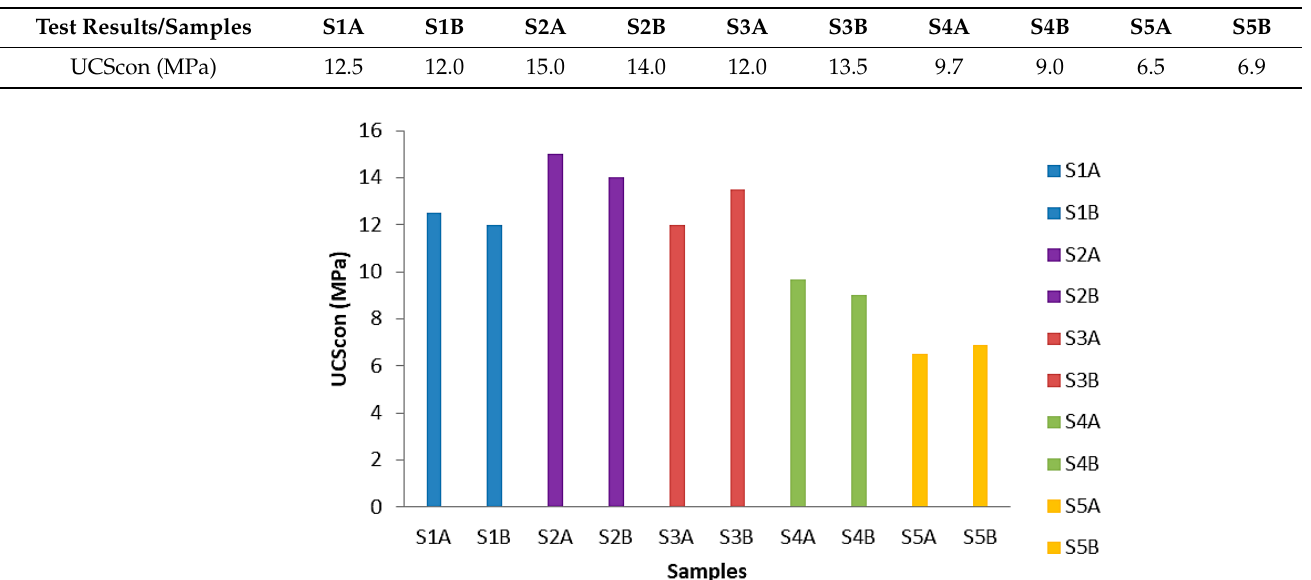
Table 5. Uniaxial compressive strength test results of the produced concrete specimens.